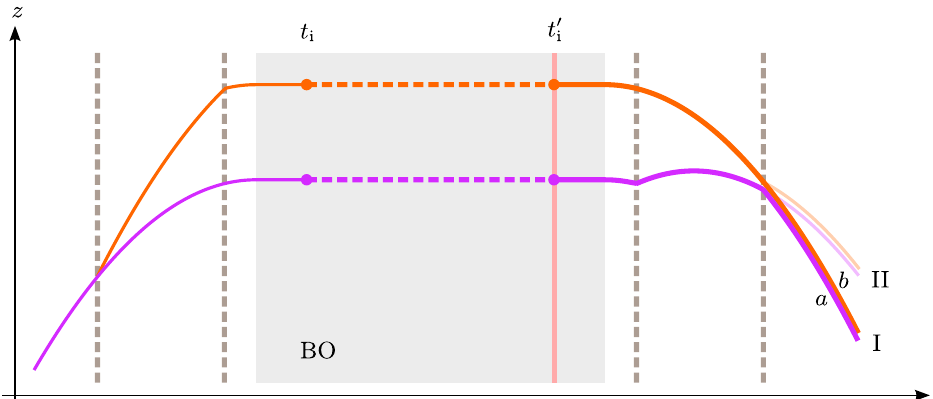
FIG. 11. Central trajectories in the laboratory frame for a hybrid interferometer involving a reversed Ramsey-Bord´e sequence combined with an optical lattice applied between the two pairs of pulses, which holds the atomic wave packets at constant height and where they undergo Bloch oscillations (BO). Doubly differential measurements are sensitive to the gravitational redshift in this case.